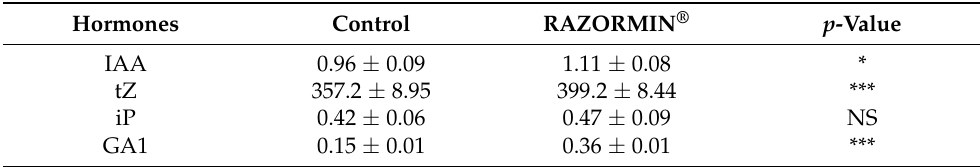
Table 3. Effect of the biostimulant RAZORMIN ® application on hormone profile (ng g − 1 DW) in pepper